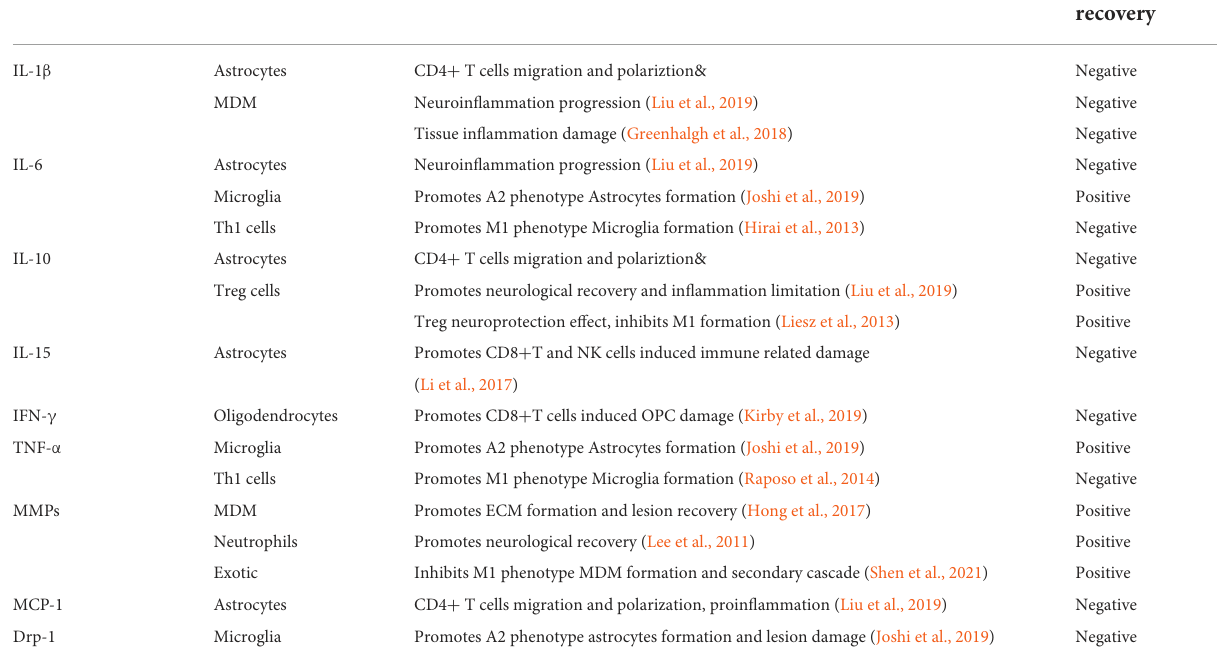
TABLE 2 The effects of SCI immunomodulation-associated cytokines.